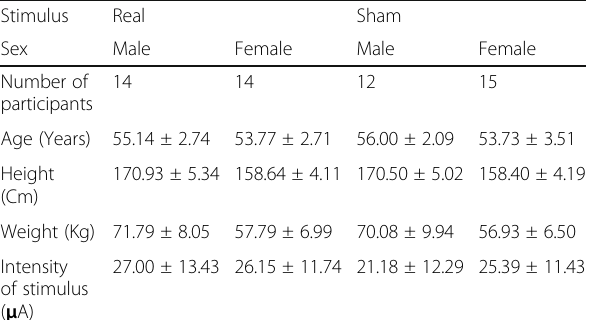
Table 1 Demographic characteristics of the participants and the average intensity of the electrical stimulation applied Stimulus Sham